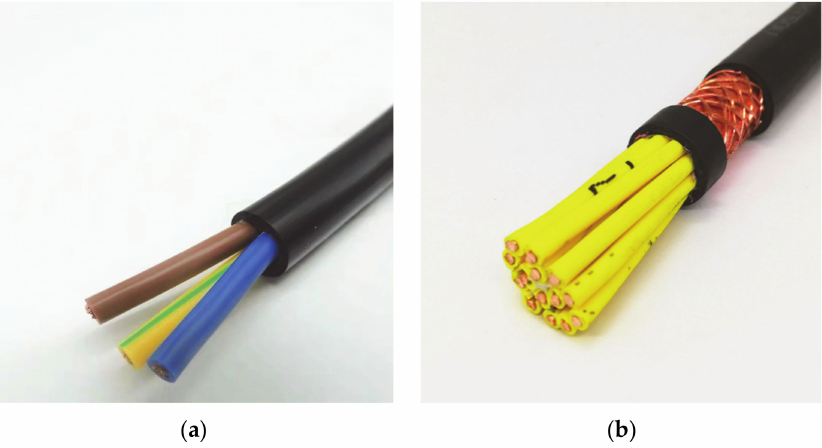
Figure 1. Photos of cables: ( a ) RVV 3*1.5 mm 2 ; ( b ) ZA-KVVP 14*1.5 mm 2 .